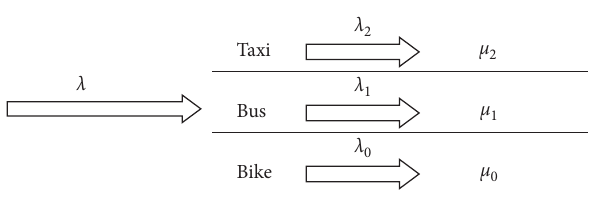
Figure 2: Scheme of public urban